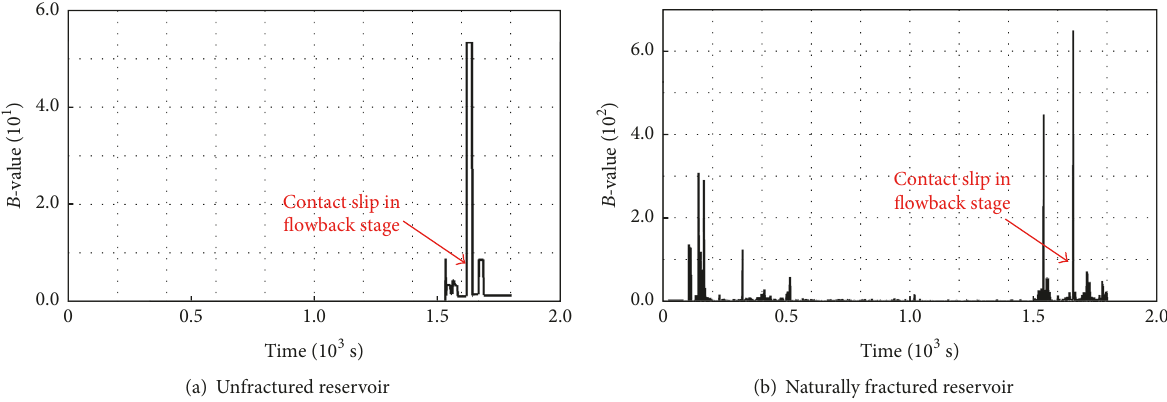
Figure 11: Evolution of 𝐵 -value for contact slip